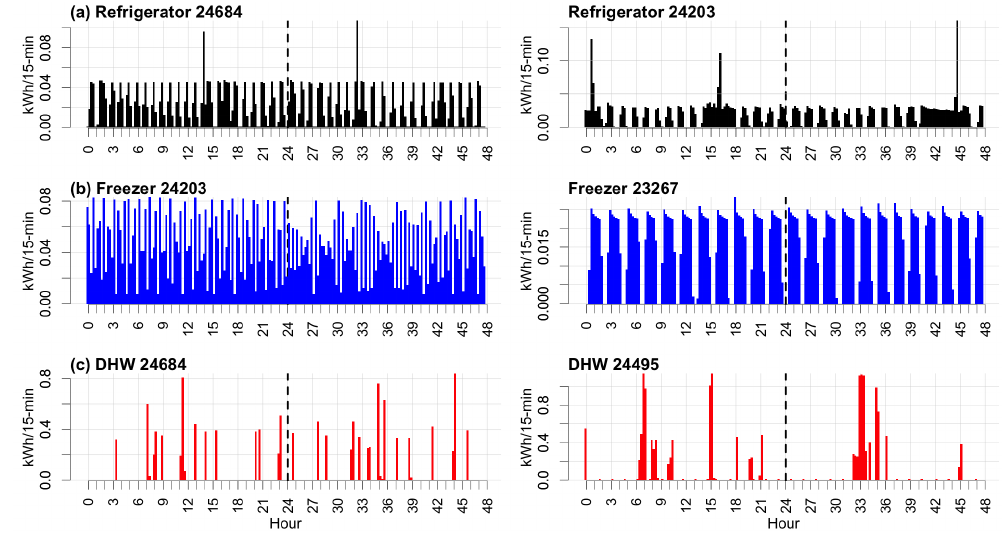
Figure 1. Energy usage of TCL appliances on 3–4 July 2012, showing kWh per 15-min